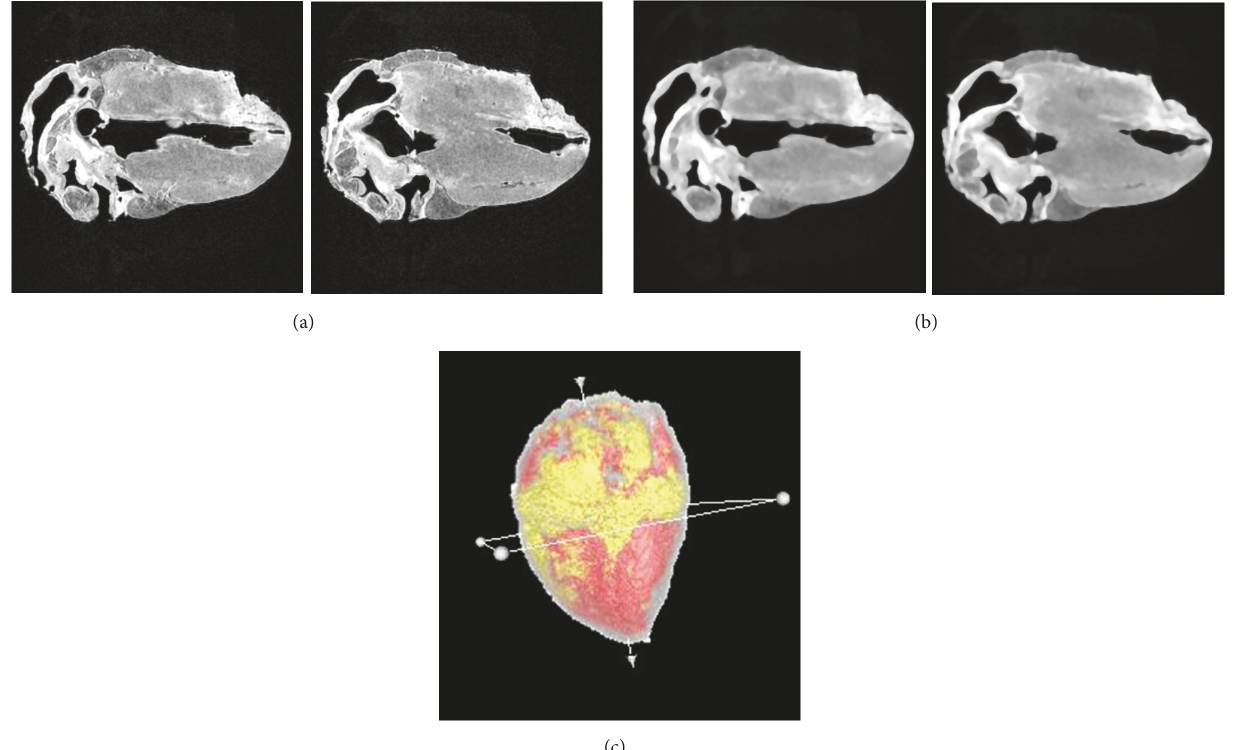
Figure 6: Visualization result of augmented sheep heart dataset with region space guided transfer function: (a) the original sheep heart data; (b) the denoised data; (c) rendering result of sheep heart with the denoised data.